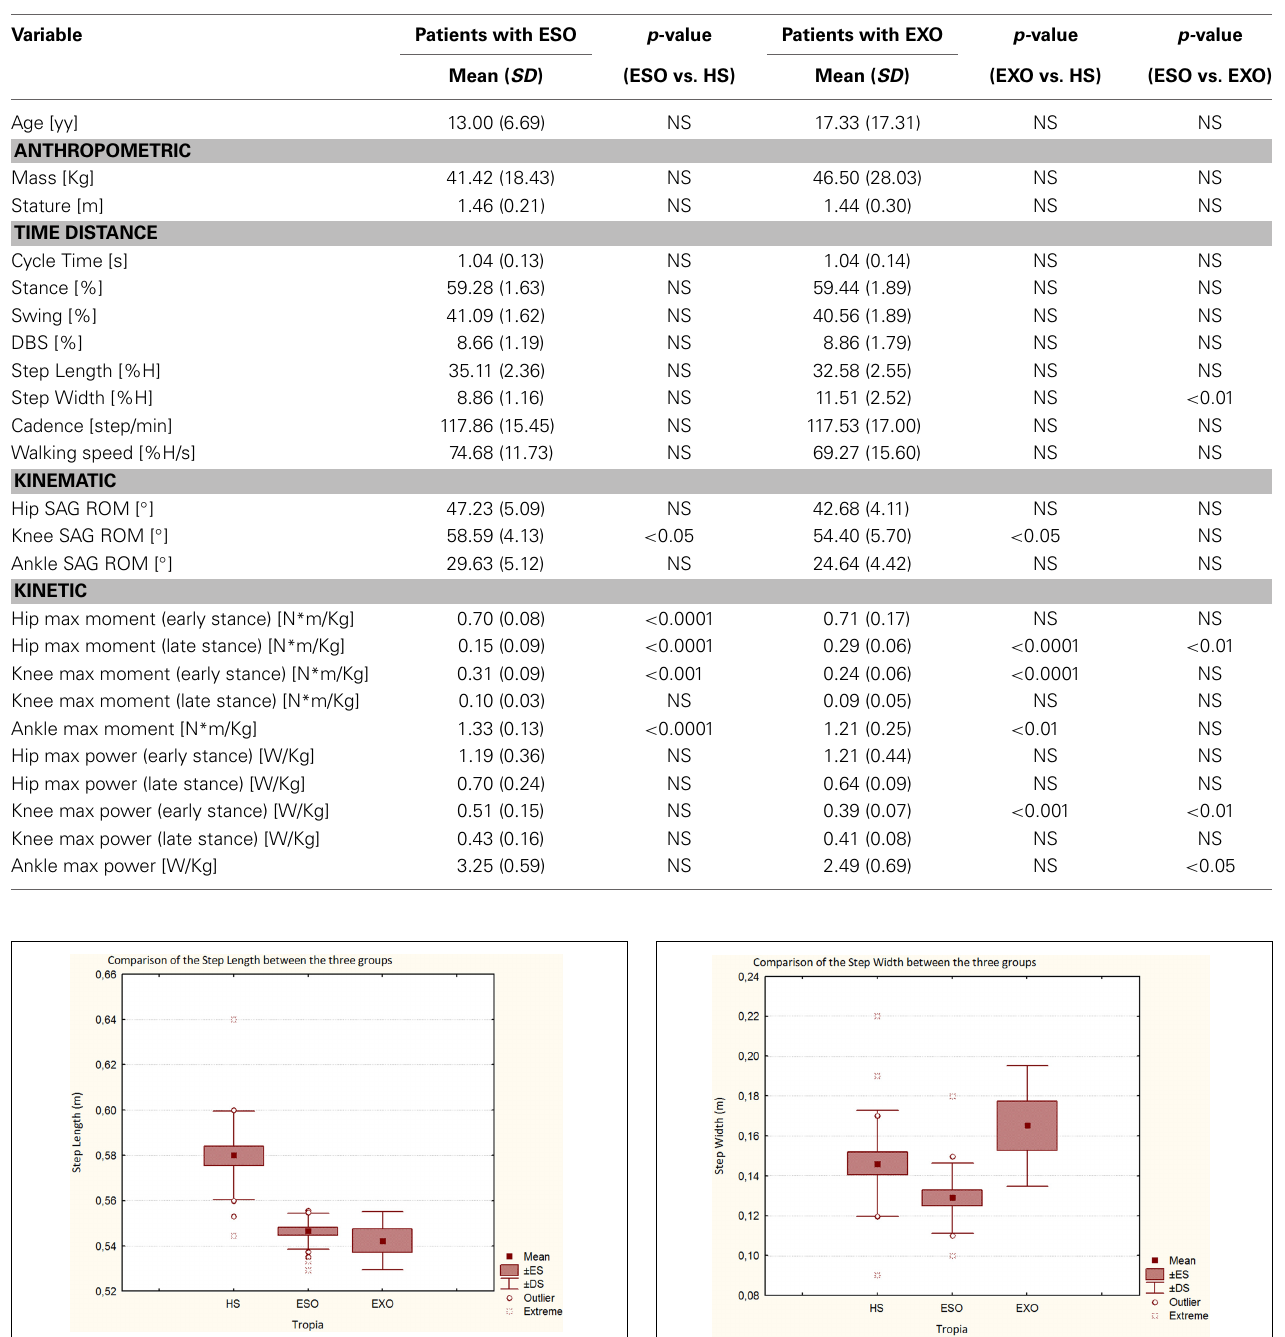
Regarding kinetic results, comparing patients with ESO and HS significant differences in hip moment (in early and late stance, p < 0 . 001), in knee moment (in early stance, p < 0 . 001), and in ankle moment were found ( p < 0 . 0001), (see Table 3